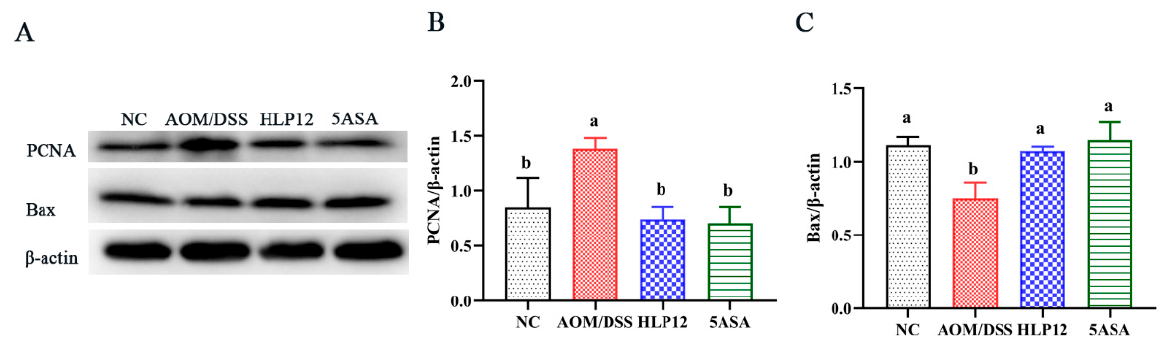
Figure 6. Effect of L. plantarum -12 oral administration on the expression of apoptosis-related proteins of the AOM/DSS-treated C57BL/6 mice. ( A – C ) PCNA and Bax in the colon of AOM/DSS-treated mice were assessed by Western blotting ( n = 4). The data with different lowercase letters are significantly different ( p < 0.05).